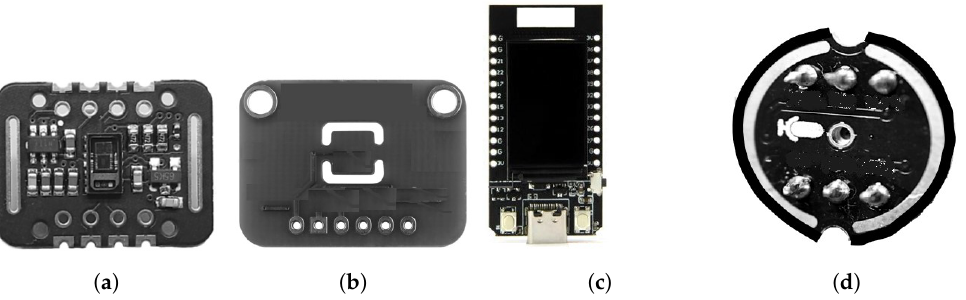
Figure 3. Sensors employed in the IoT Modules. ( a ) MAX30102; ( b ) BlueDot TMP117; ( c ) ESP32; ( d )